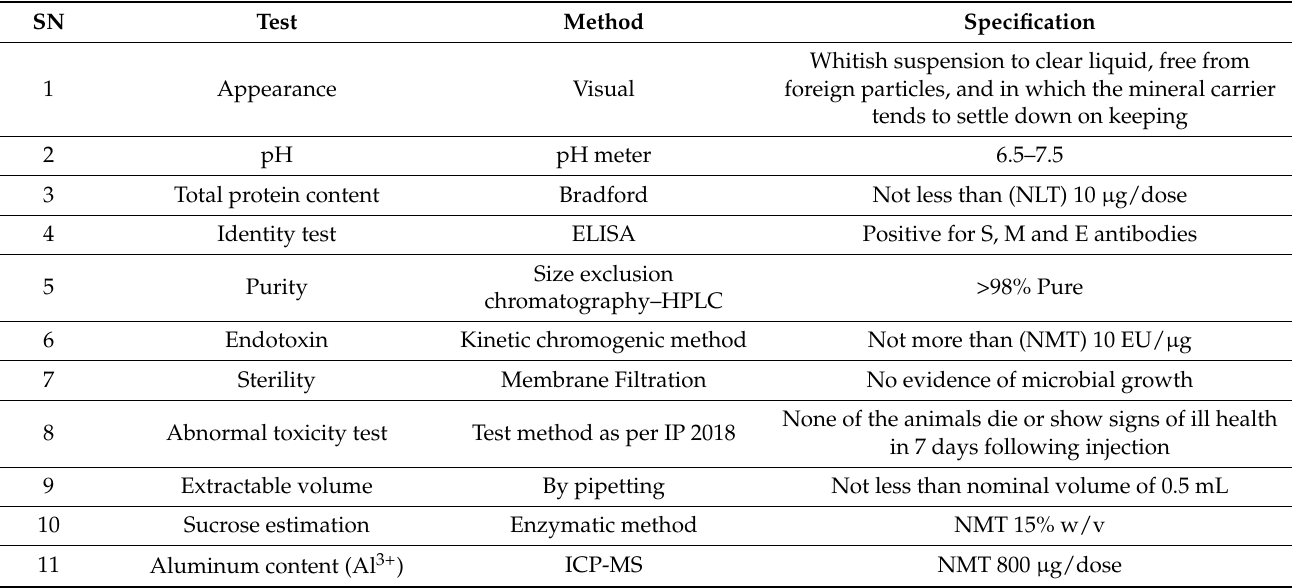
Table 2. Specifications of